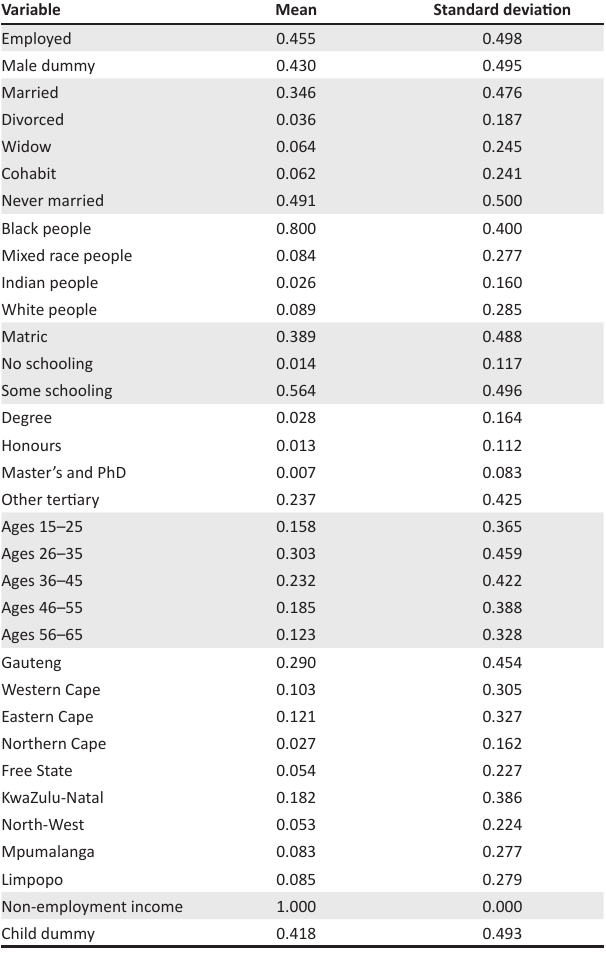
TABLE 1: Summary statistics for